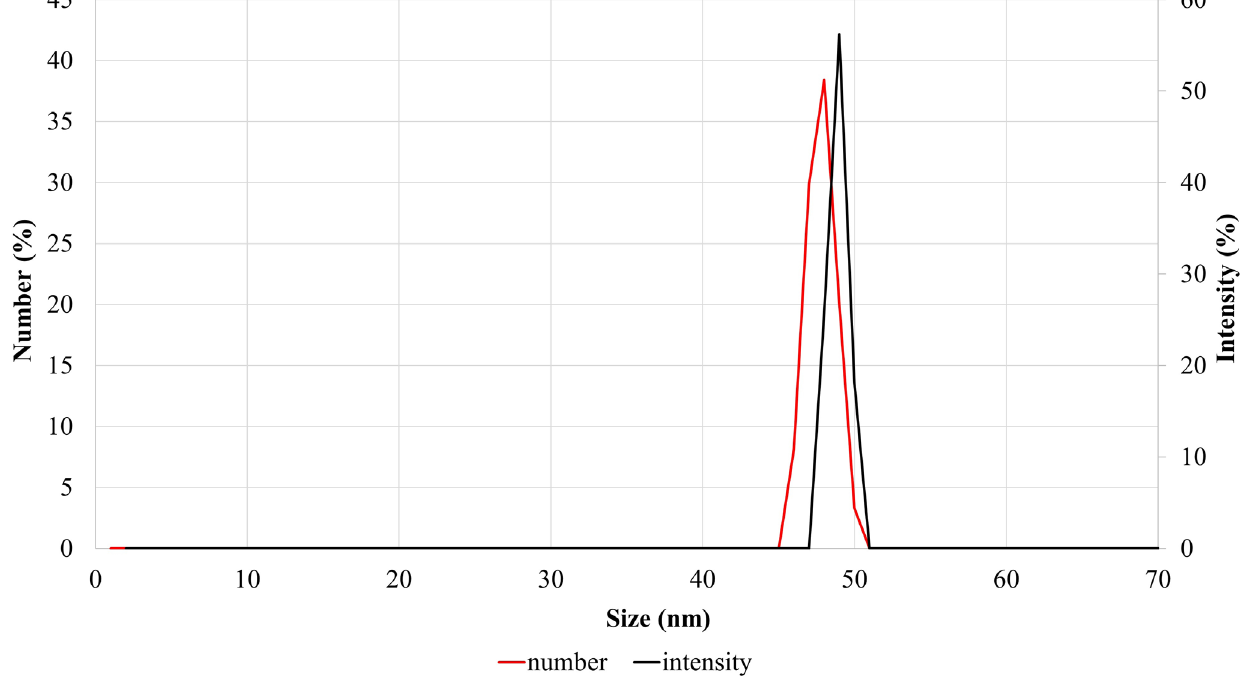
=0.33 wt% ; [ b -CD coated magnetite] final